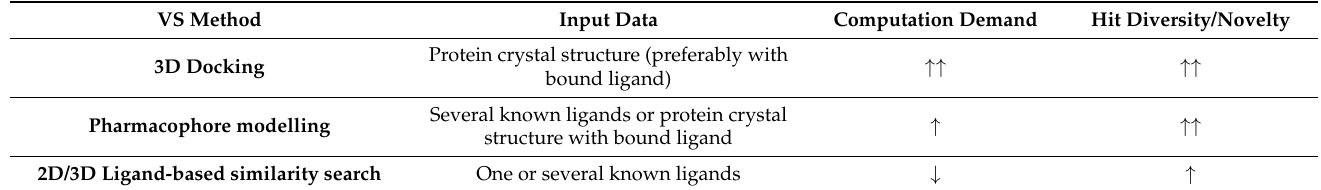
Figure 1. Overview of the virtual screening approaches leading to a focused library for biological screening. [5]. The various virtual screening methods are compared in Table 1. Table 1. Comparison of the virtual screening methods (modified based on [5]).